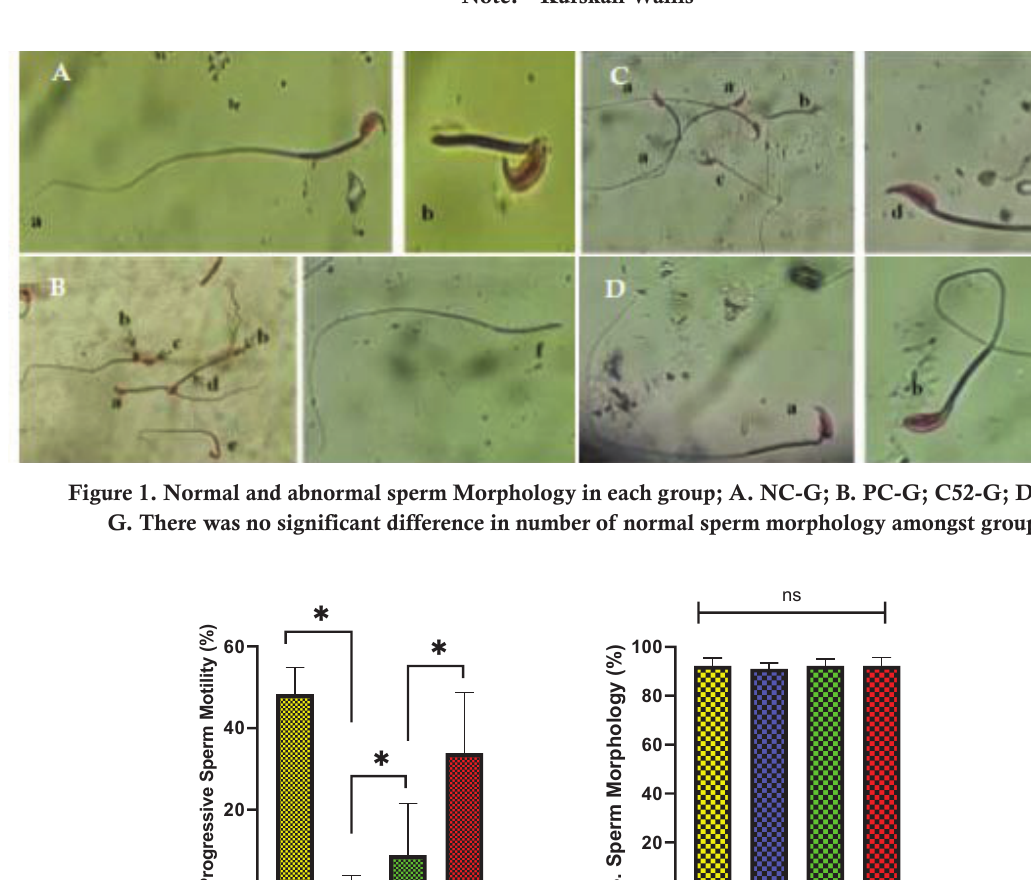
Note: * Kurskall Wallis